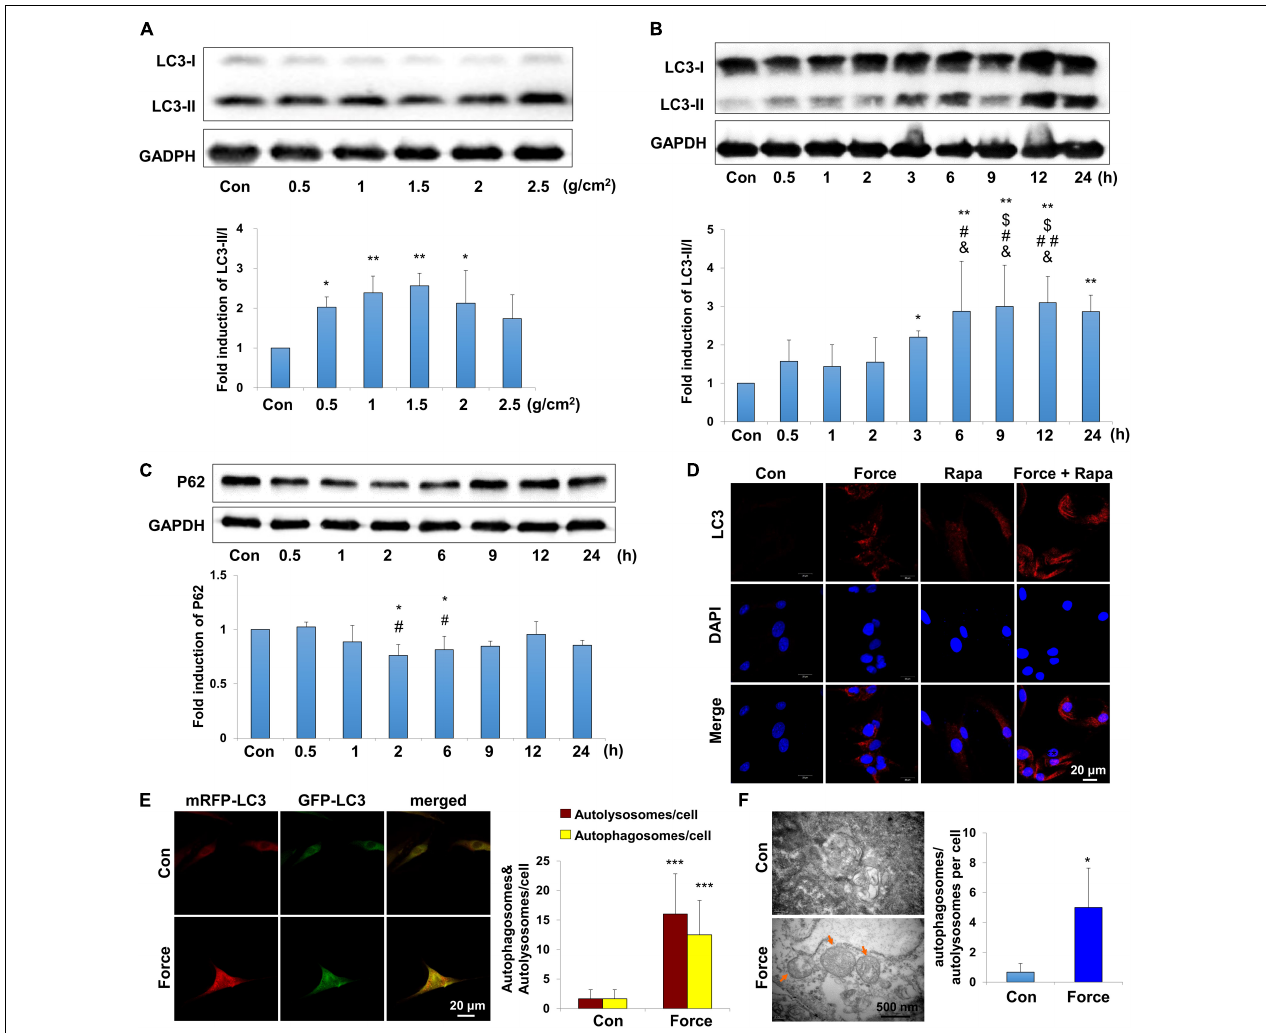
FIGURE 2 | Autophagy is induced with the application of mechanical stimuli in PDLSCs. (A) Western blot of the expressions of LC3 in PDLSCs under different force values at protein level. The relative fold change of LC3-II/I was quantified. GAPDH served as an internal control for equal loading. Results are presented as mean ± SD. n = 3–4. ∗ P < 0.05, ∗∗ P < 0.01 versus Con. (B) Western blot of the expressions of LC3 in PDLSCs under force stimuli (1.5 g/cm 2 ) at different time points. The relative fold change of LC3-II/I was quantified. GAPDH served as an internal control for equal loading. Results are presented as mean ± SD. n = 3–4. ∗ P < 0.05, ∗∗ P < 0.01 versus Con; $ I P < 0.05 versus 0.5 h; # P < 0.05, ## P < 0.01 versus 1 h; & P < 0.05, && P < 0.01 versus 2 h. (C) Western blot and quantification of P62 expression in PDLSCs under force stimuli (1.5 g/cm 2 ) at different time points. Results are presented as mean ± SD. n = 3. ∗ P < 0.05 versus Con; # P < 0.05 versus 0.5 h. (D) Immunofluorescence staining of LC3 (red) in PDLSCs with the application of force stimuli (1.5 g/cm 2 ) or rapamycin (Rapa). (E) PDLSCs were infected with adenovivus with mRFP-GFP-LC3. Cells were applied with static force for 6 h, and the autophagosomes and autolysosomes were detected in PDLSCs. Yellow-colored autophagosomes and red-colored autolysosomes were calculated. Results are presented as mean ± SD. n = 4. ∗∗∗ P < 0.001 versus Con. (F) Ultrastructural features in PDLSC assessed by TEM without or with force. Arrows indicated the autophagosomes or autolysosomes in the cytoplasm. Numbers of autophagosomes/autolysosomes were quantified. Results are presented as mean ± SD. n = 3. ∗ P < 0.05 versus